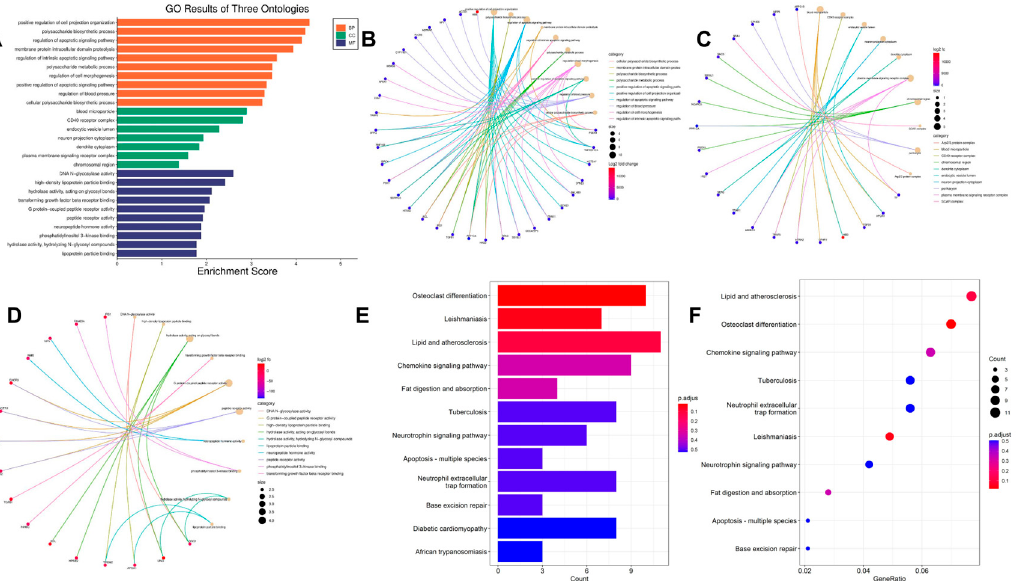
Figure 4. Functional characteristics analysis for the co-DEGs. ( A ) GO enrichment results of three ontologies. ( B ) The BP category of GO enrichment analyses. ( C ) The CC category of GO enrichment analyses. ( D ) The MF category of GO enrichment analyses. ( E ) The barplot of KEGG pathway enrichment results. ( F ) The dotplot of KEGG pathway enrichment results.